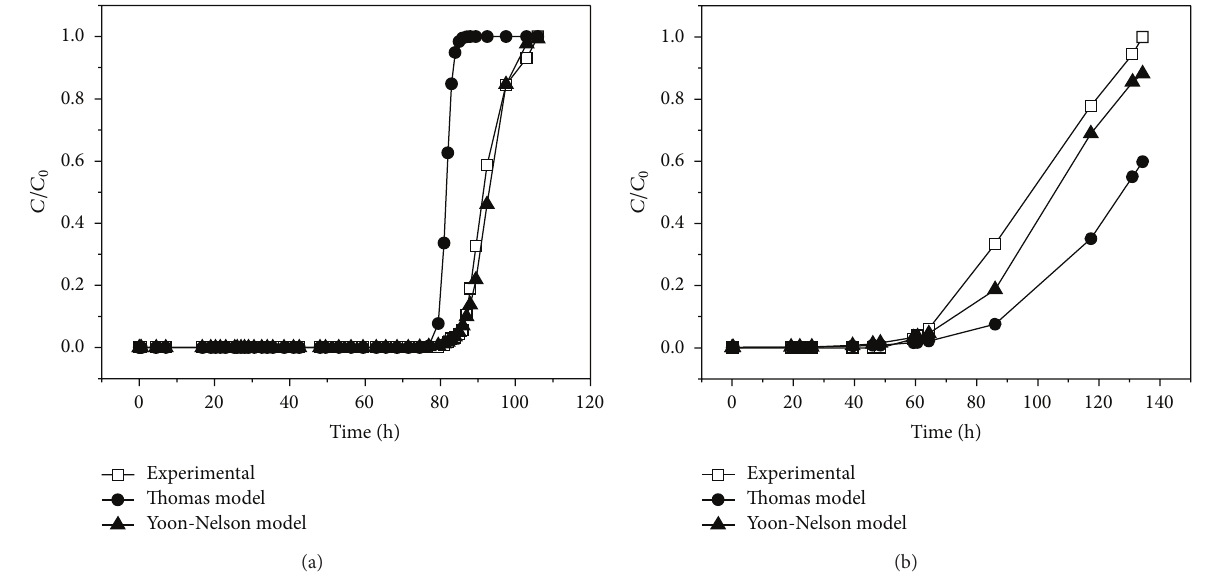
Figure 8: Predicted breakthrough curves of (a) HCl and (b) VCM on 6N NaOH/GAC using different two models.